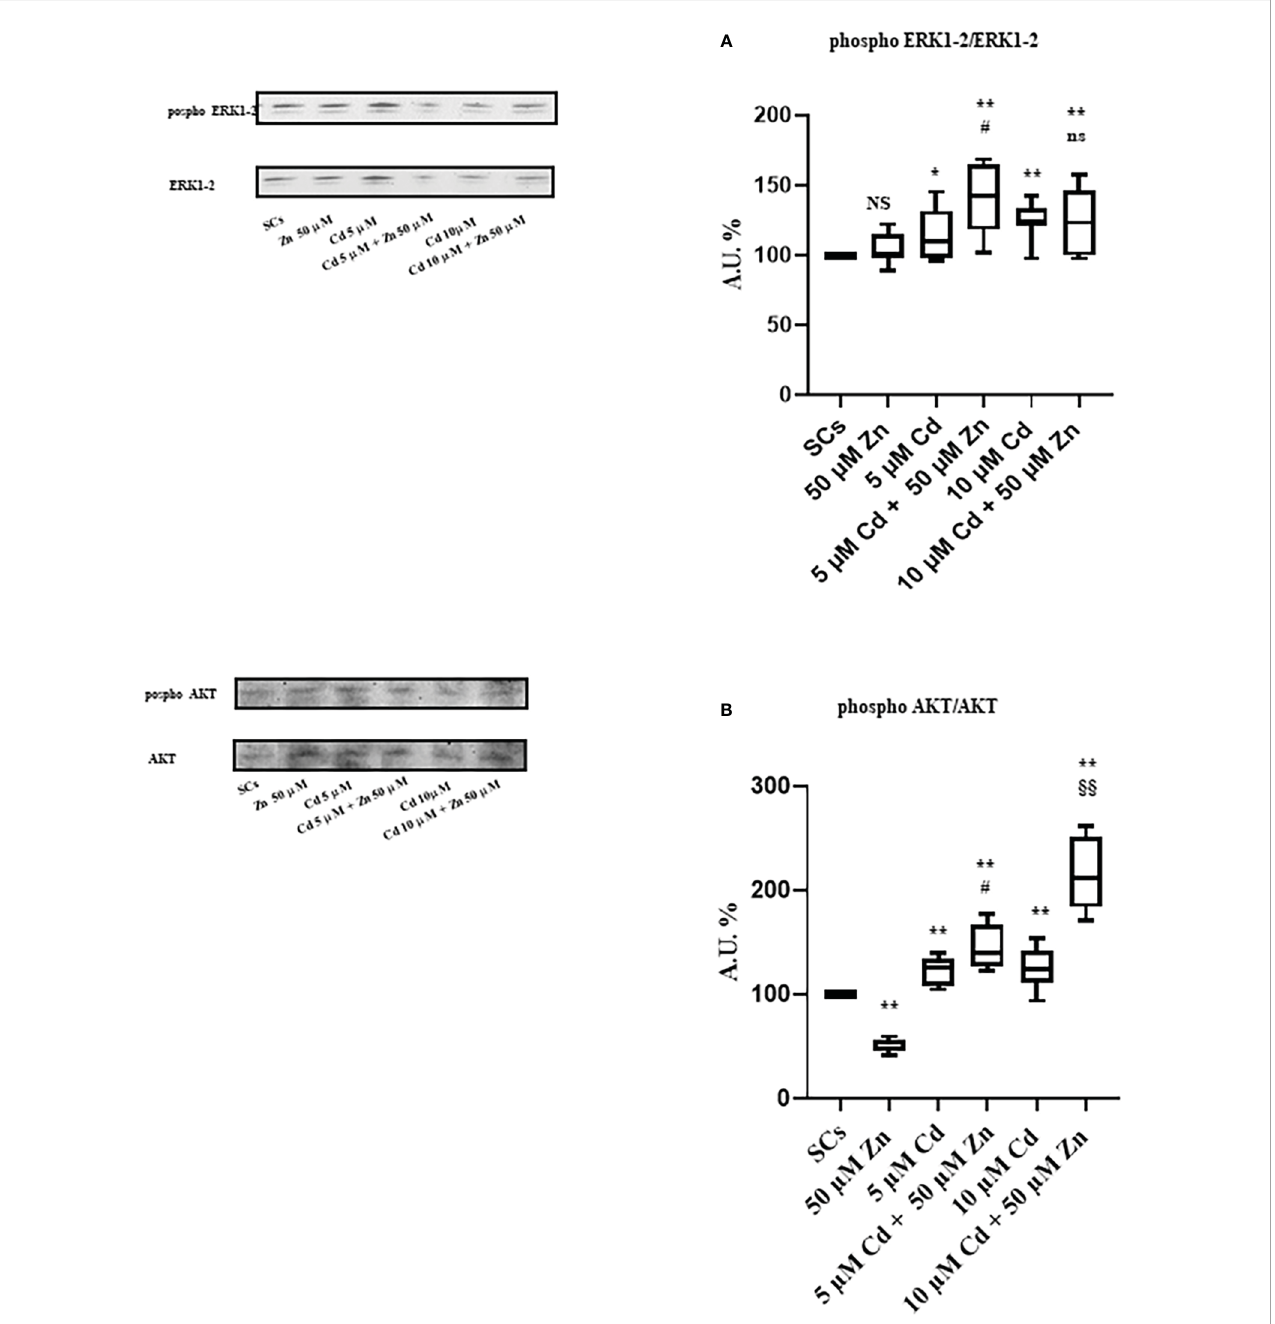
FIGURE 10 WB analysis of ERK1/2 and AKT pathways. (A) Immunoblots (upper left) and densitometric analysis (upper right) of the phosphorylation ratio of ERK1/2 in the absence (unexposed-control group, SCs) or presence of 5 or 10 µM CdCl 2 and/or 50 m M ZnCl 2 for 48 h. (B) Immunoblots (lower left) and densitometric analysis (lower right) of phosphorylation ratio of AKT in the absence (unexposed-control group, SCs) or presence of 5 or 10 µM CdCl 2 and/ or 50 µM ZnCl 2 for 48 h. Data presented as the mean ± SEM (NS vs . SCs, * p < 0.05 and ** p < 0.001 vs . SCs, # p < 0.05 vs . 5 µM Cd, §§ p < 0.001 vs . 10 µM, ns vs . 10 m M of three independent experiments, each performed in triplicate) [* p < 0.05 and ** p < 0.001, with respect to unexposed SCs (black dotted line) of three independent experiments, each performed in triplicate]. A.U., arbitrary